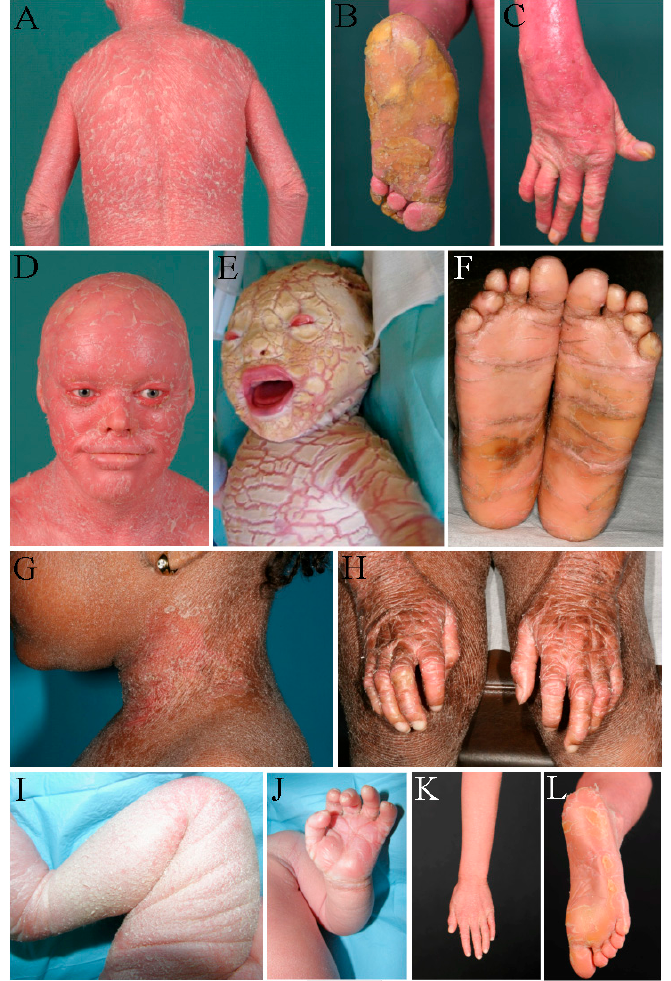
Figure 2. ( A – D ) Harlequin ichthyosis in patient 36. ( A ) Generalized dry and red scaly skin on the back, ( B ) palmoplantar hyperkeratosis, ( C ) joint contractures at fingers and thickened fingernails, and ( D ) face with red, scaly skin, ectropion, and hypoplastic ears. ( E ) Harlequin ichthyosis in patient 26 at the day of birth. Large thick plates separated by deep cracks. Ectropion, eclabion, hypoplastic nose and ears. ( F – H ) Lamellar ichthyosis in patient 48. ( F ) Palmoplantar hyperkeratosis, ( G ) ichthy- otic skin on the neck, and ( H ) skin with large dark scales and contractures of fi ngers. ( I – L ) Congen- ital ichthyosiform erythroderma in patient 26. ( I ) Thickened skin with white scales in a newborn, ( J ) erythroderma of the palms, ( K ) generalized erythroderma with fi ne white scales, and ( L ) palmoplantar hyperkeratosis.